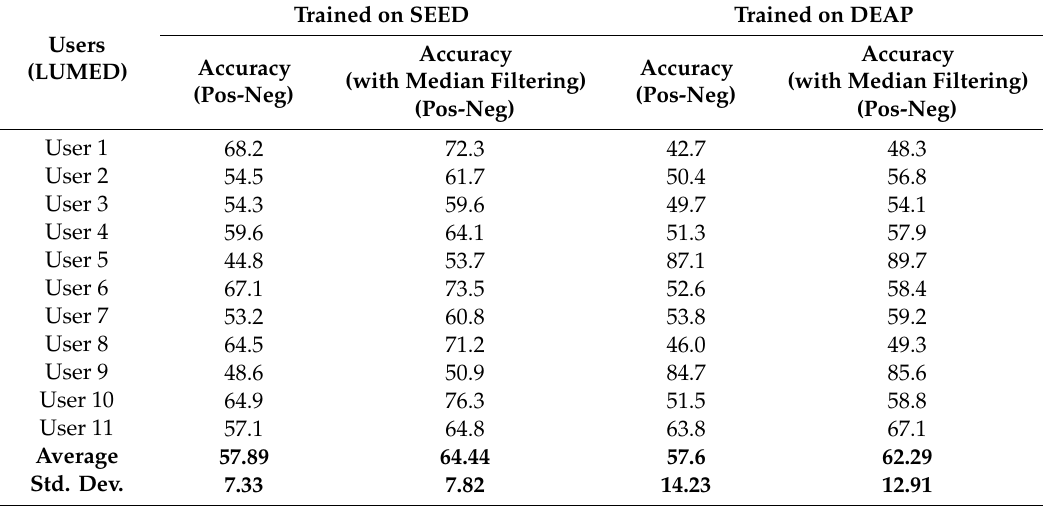
Table 10. Cross-dataset prediction accuracy results (Trained on the SEED / DEAP and tested on the